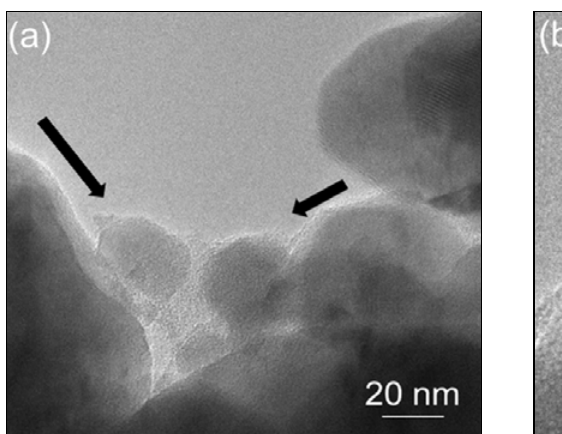
O /C composite. 2 4